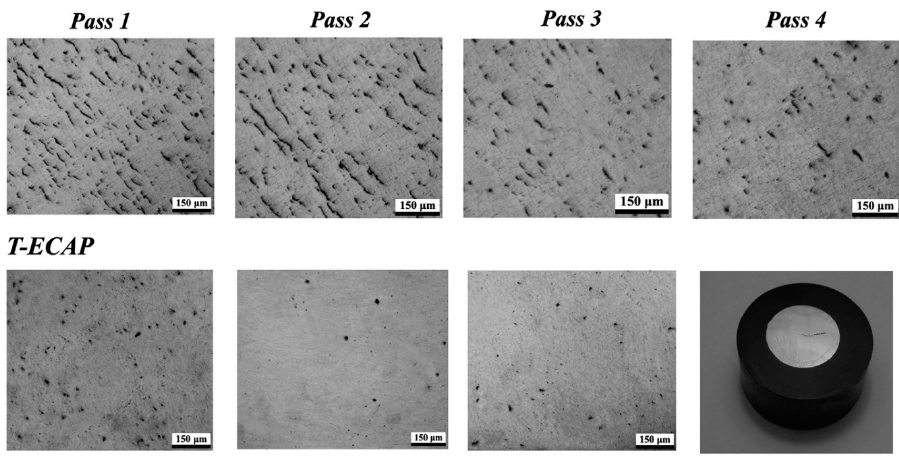
Figure 18. Metallographic images: Relative densities of the ECAP and T-ECAP billets [87].